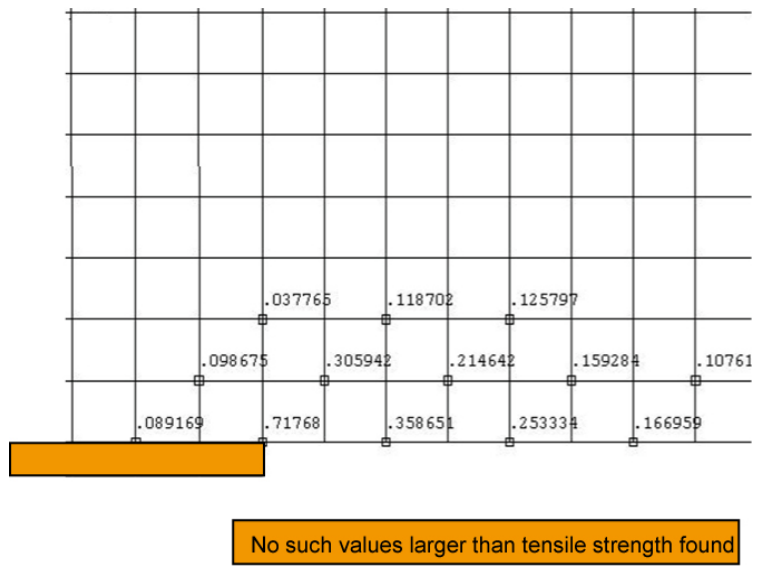
Figure 19. The specific value around the region at the end of the